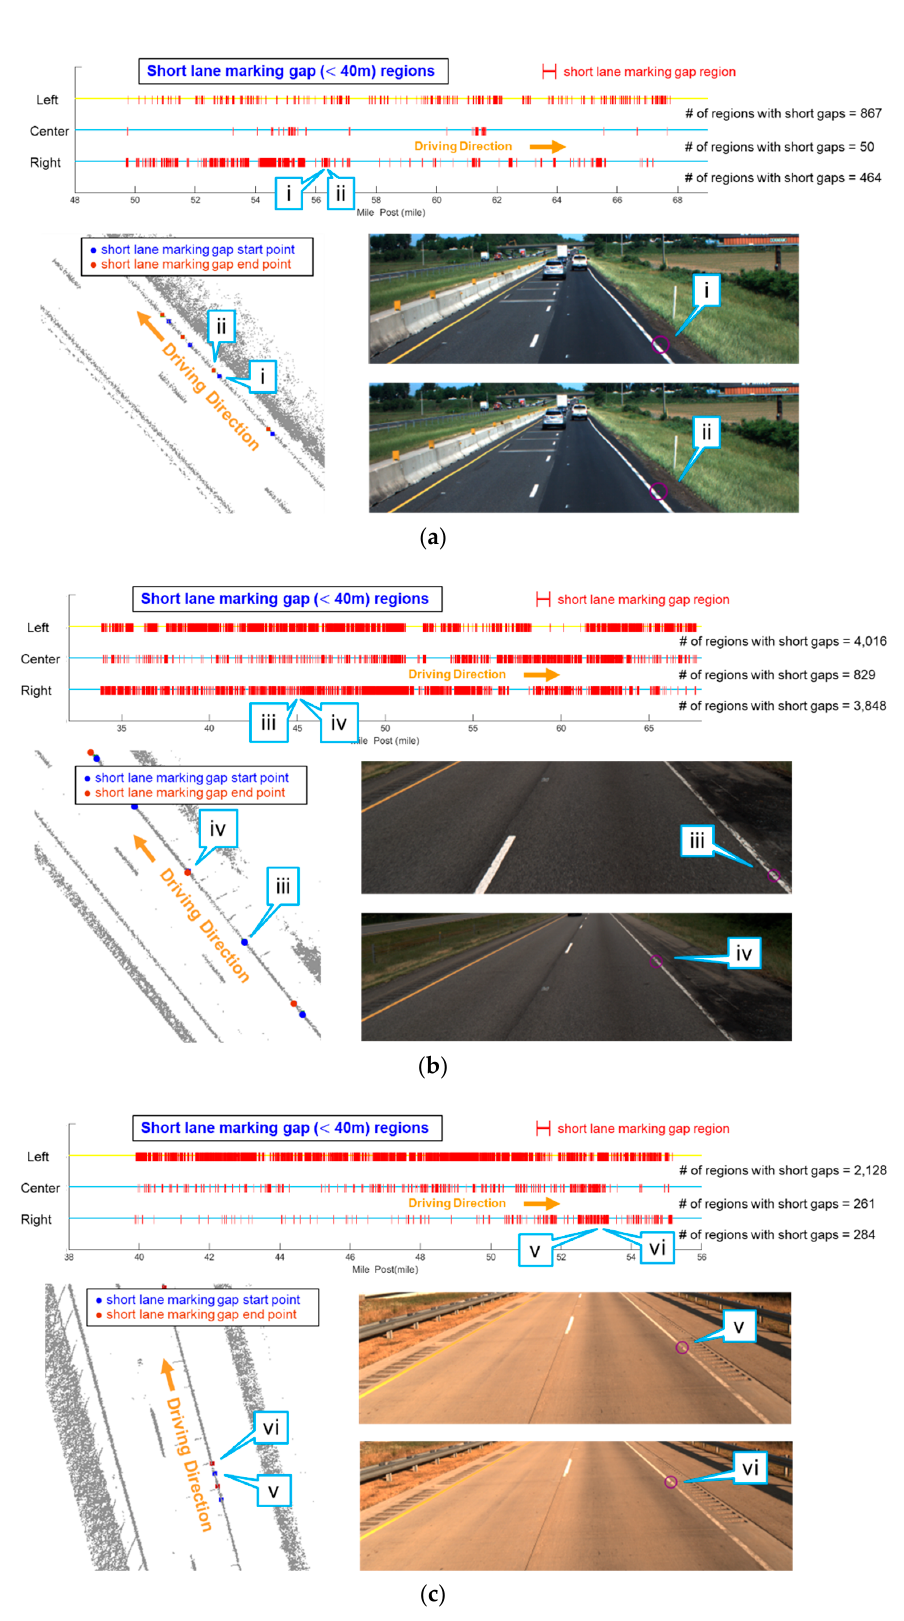
Figure 35. Illustrations of short lane marking gap regions versus mile marker (top) together with an example location defined by start and end points overlaid on hypothesized lane markings (bottom-left), and corresponding RGB imagery (bottom-right) for ( a ) dataset 1, ( b ) dataset 2, and ( c ) dataset 3.